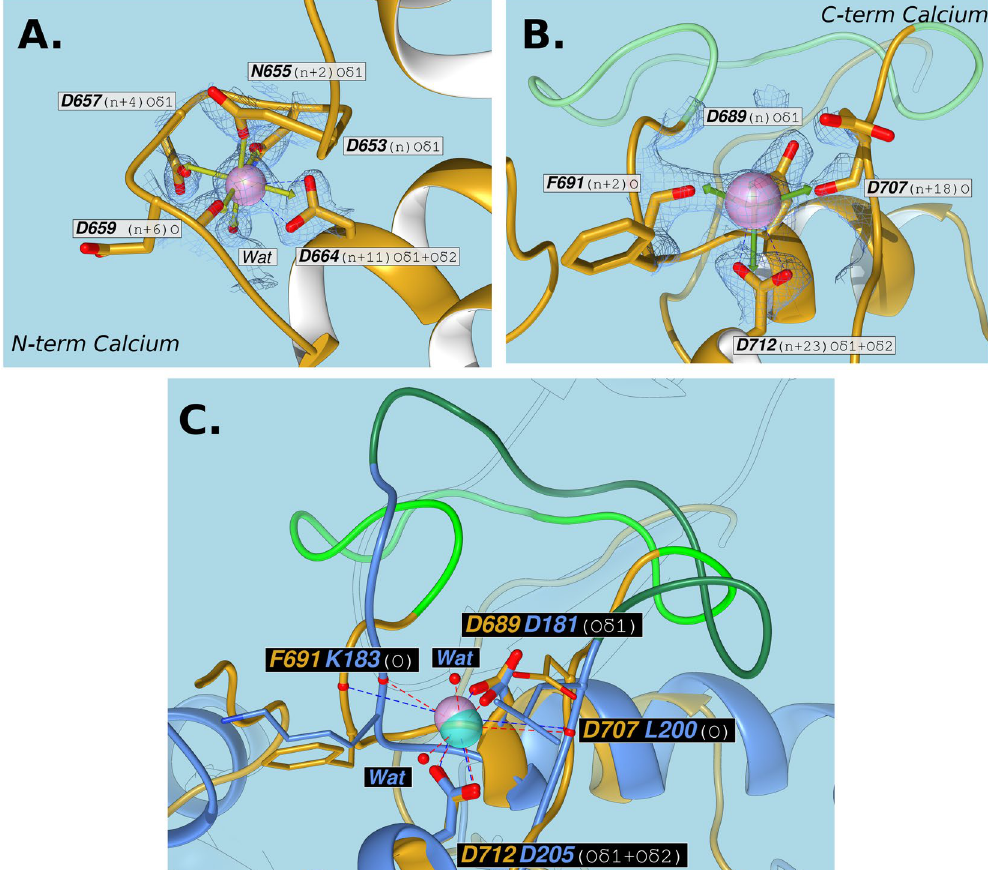
Figure 3. Calcium-coordination geometry at the N-terminal and C-terminal F-hand motifs of R. flavefaciens DocScaA. Panels A and B show a representation of Rf DocScaA N- and C-terminal Ca 2 + -coordination regions, respectively. In both panels the amino-acid residues involved in the metal coordination are depicted as sticks, surrounded by a mesh representation of the Refmac5 maximum-likelihood σ A –weighted 2F o − F c electron density map contoured at 1 σ (0.46 electrons/A 3 ). The labels show the Rf DocScaA residue and coordination position numbers and also the atoms involved. Both calcium ions are depicted as purple spheres and are overlaid with an idealized geometry representation (green arrows), which is pentagonal bipyramidal for the N-terminal Ca 2 + (Panel A) and tetrahedral for the C-terminal Ca 2 + (Panel B). A single water molecule (Wat) completes the coordination sphere of the N-terminal Ca 2 + ion (Panel A). The bidentate nature of the Asp-664 and Asp-712 coordination is highlighted with blue dashed lines (Panels A and B). The 12-residue insert at the C-terminal calcium coordination loop is colored in light green (Panel B). Panel C depicts the overlay of the C-terminal Ca 2 + of Rf DocScaA (purple) with the C-terminal Ca 2 + of the group 4 dockerin of Rf DocCttA (cyan), whose coordination is also disrupted by a 13-residue long insert (dark green), but maintains an octahedral geometry due to the contribution of 2 water molecules (Wat). The structure of Rf DocScaA is colored tan, and the structure of Rf DocCttA is colored